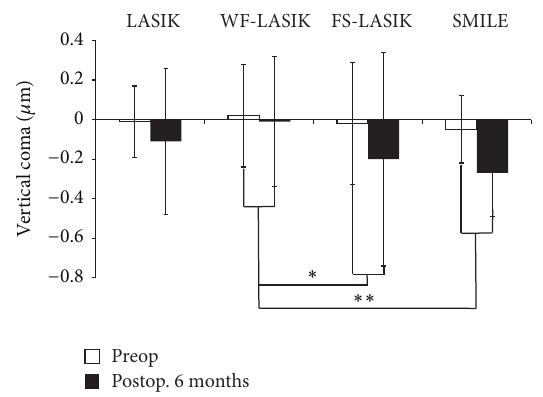
Figure 4: Comparison of the vertical coma changes in four groups. Comparison of the induced vertical coma between wavefront- guided LASIK and both femtosecond laser-assisted LASIK ( ∗ 𝑃 value is0.015)andsmallincisionlenticuleextraction( ∗∗ 𝑃 valueis < 0.001). Positive and negative values indicate an average positive or negative shift, respectively, in vertical coma relative to preoperative